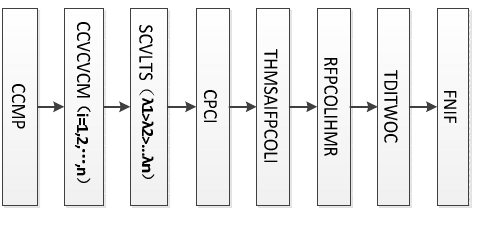
Figure 1-1 Technical flowchart of principle component instead CCMP: Calculate correlation matrix produced by image. CCVCVCM: Calculate characteristic value